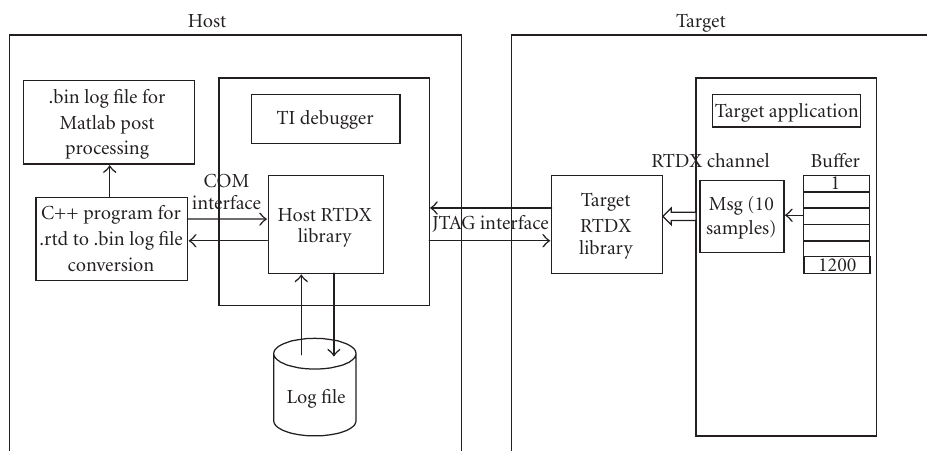
Figure 9: RTDX in snapshot